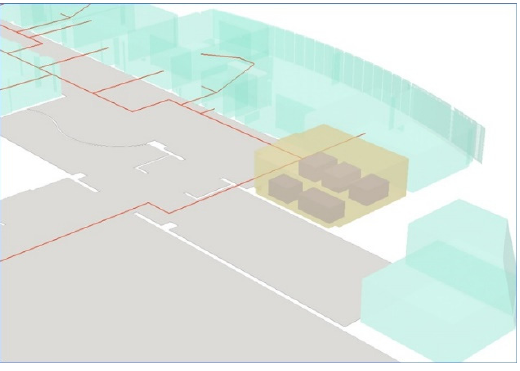
Figure 16. Selected room for generating a Level 4 network considering facilities.